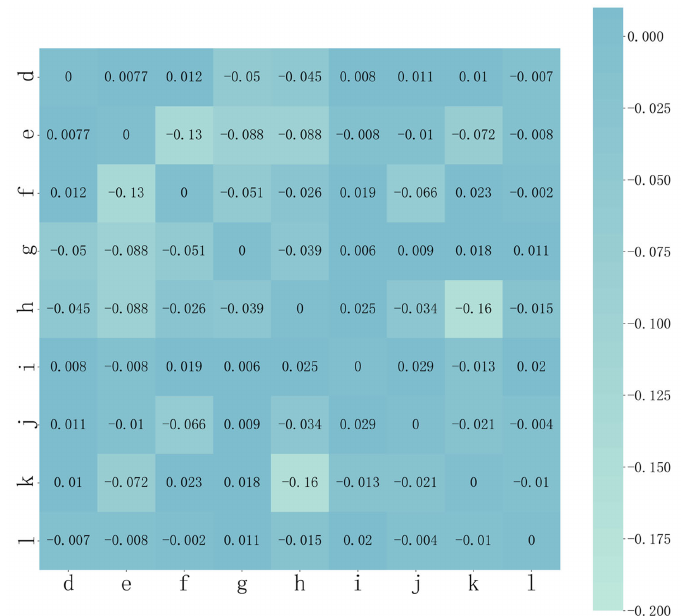
Figure 10. Heat map of second-order sensitivity of RV reducer rotation error.